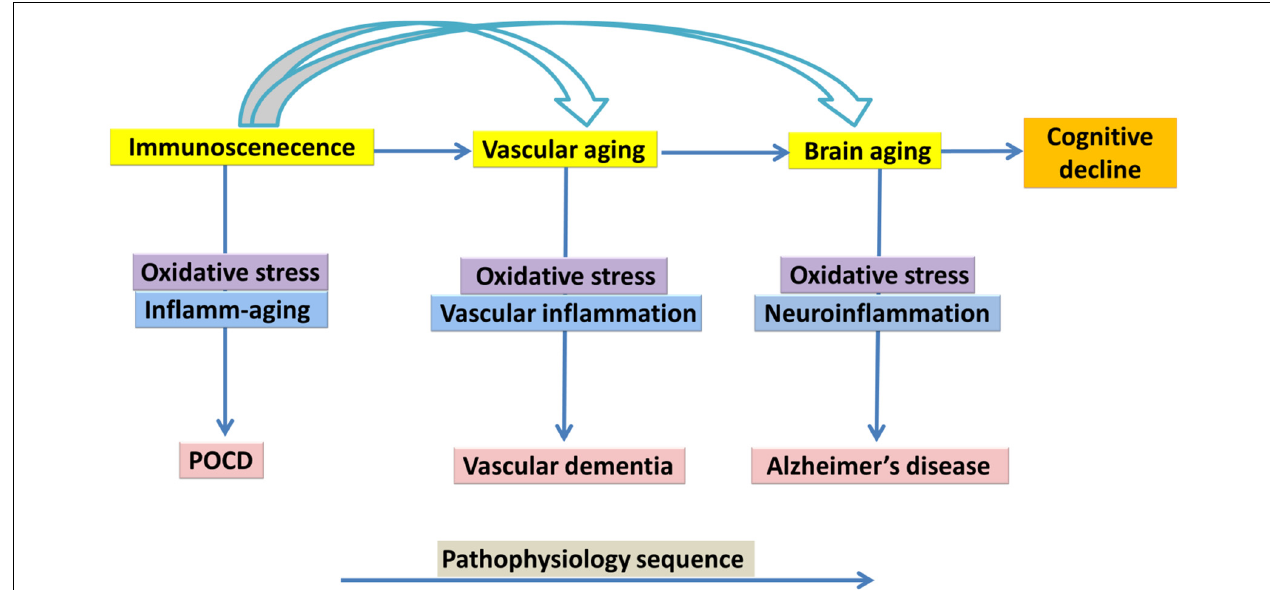
FIGURE 1 | Immunosenescence, vascular aging, brain aging in association with cognitive decline, a suggested model of underlying mechanism.